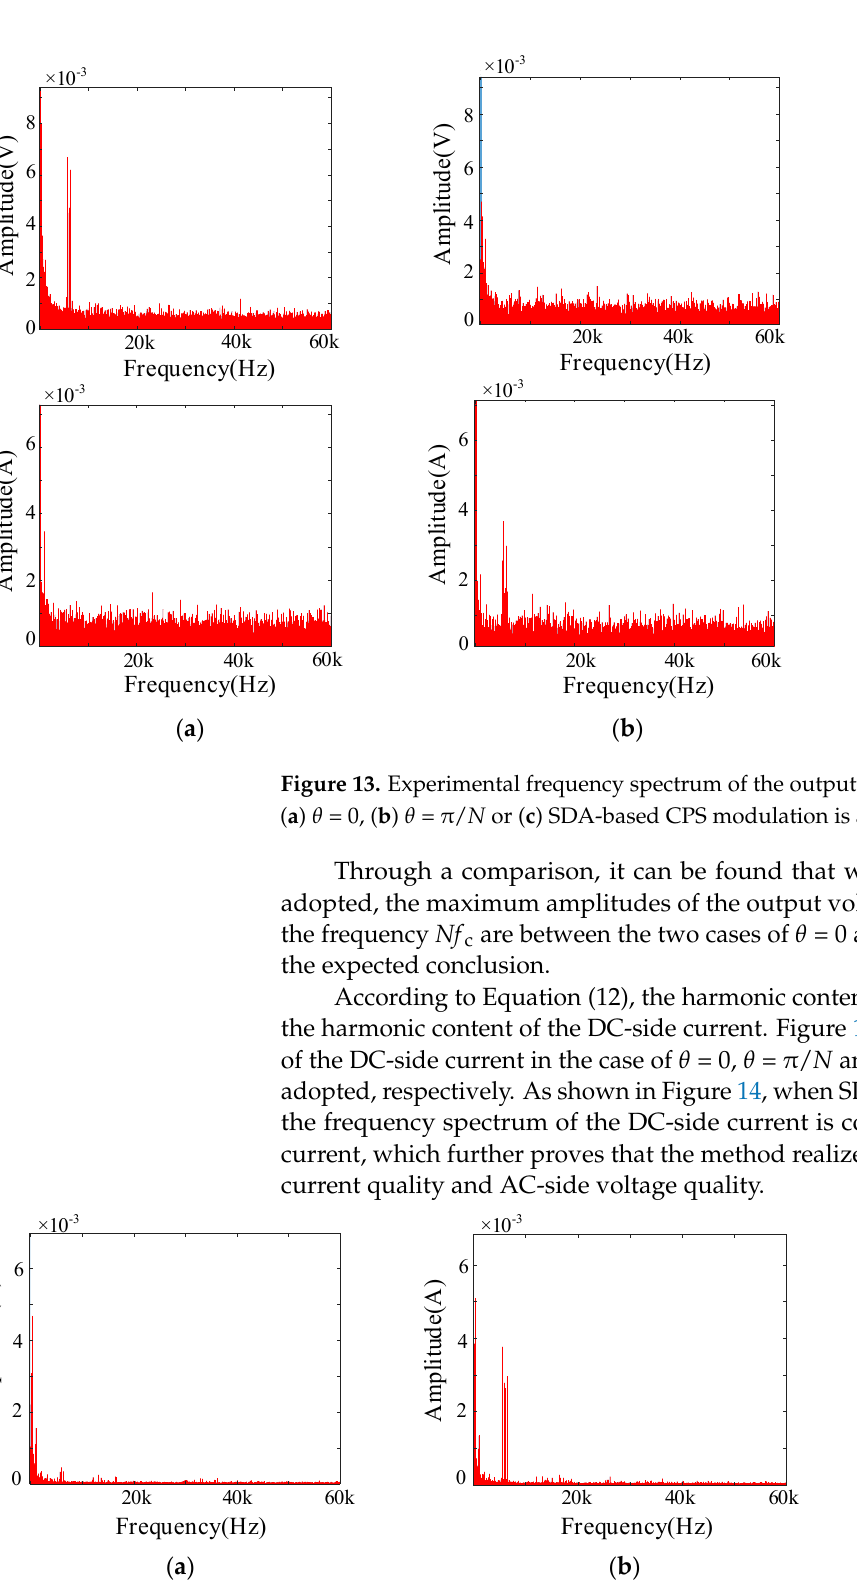
Figure 14. Experimental frequency spectrum of DC-side current when ( a ) θ = 0, ( b ) θ = π / N or ( c ) SDA-based CPS modulation is adopted.